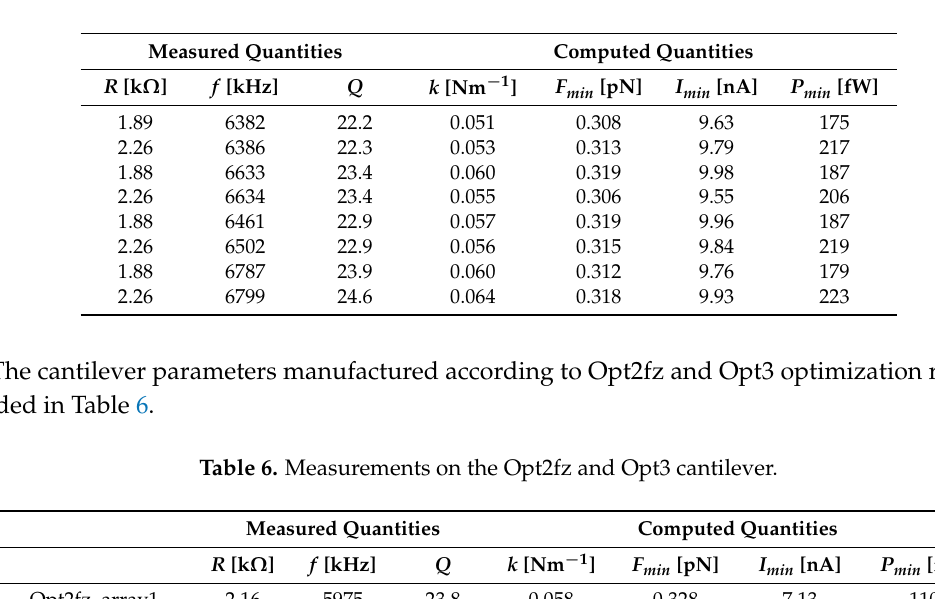
Table 5. Measurements on the initial cantilever.